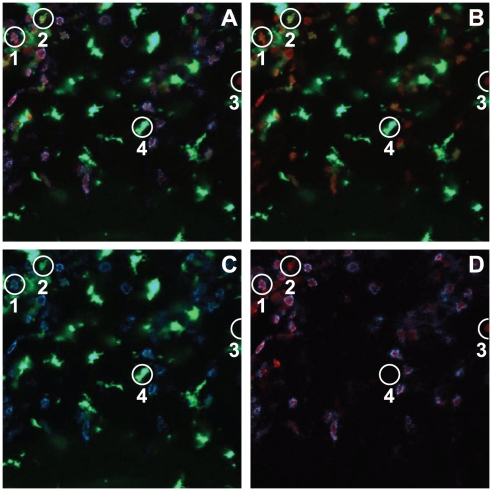
Analysis of monocyte subsets in brain lesions of EAE Ccr2RFP/+Cx3cr1GFP/+ mice at peak EAE.Confocal images of the periventricular lesions were obtained after staining with the 7/4 antibody. Images represent the same lesion (A) Merged images of red/CCR2, green/CX3CR1, and blue/7/4. (B) Red/CCR2 and green/CX3CR1. (C) Blue/7/4 and green/CX3CR1. (D) Red/CCR2 and blue/7/4. The majority of CCR2+ cells are 7/4+ and CX3CR1lo or negative, suggesting that they are classical infiltrating monocytes (see individual cell “1”). Ly6Clo monocytes (CX3CR1hi and CCR2) are also present (cell “2”), as well as T cells (“3”) and activated microglial cells (“4”).